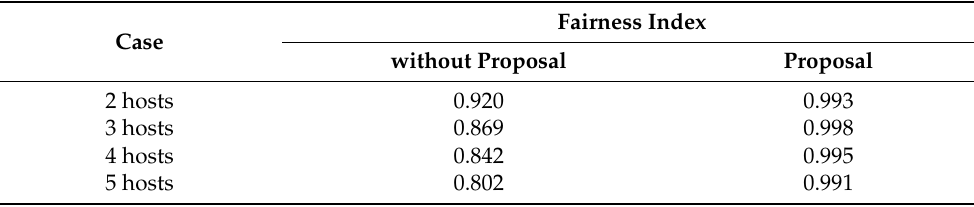
Table 6. Fairness index comparison for equal throughput scenario .